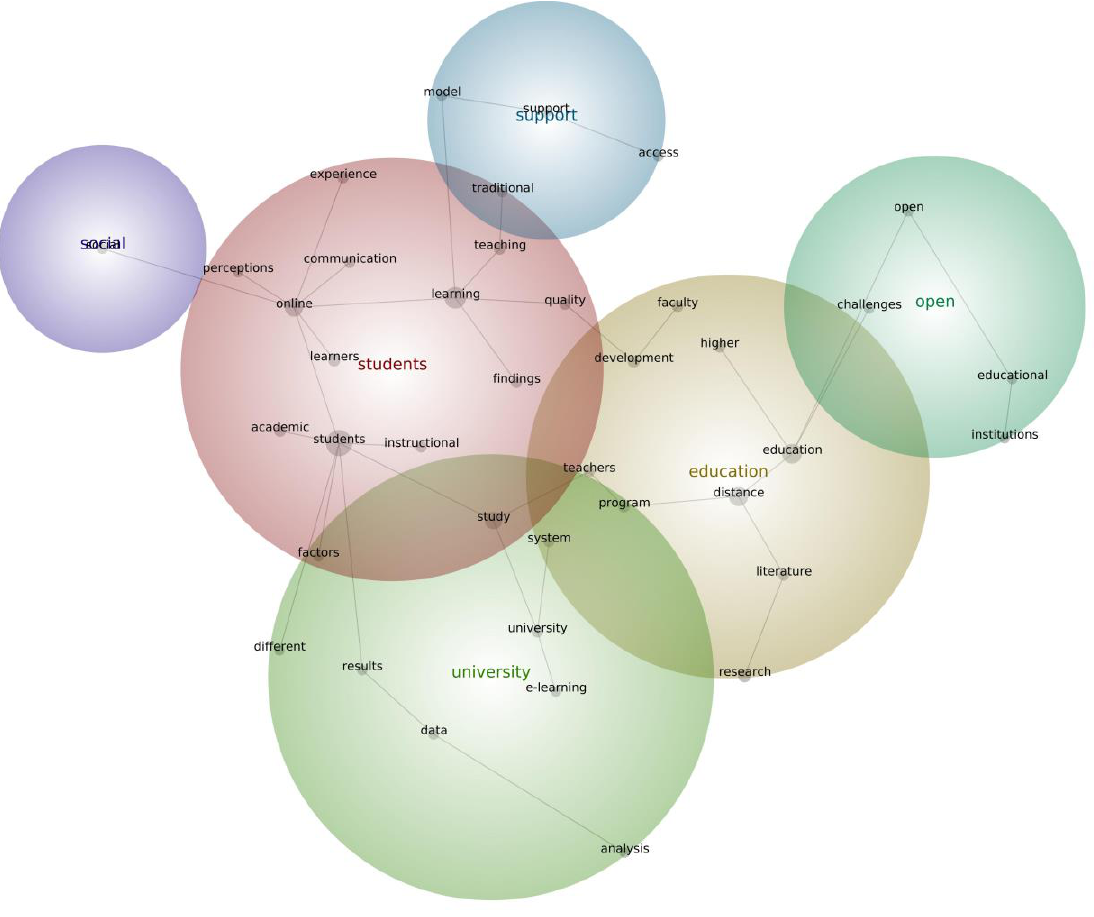
Figure 3. Concept map of widening access to education and online learning support